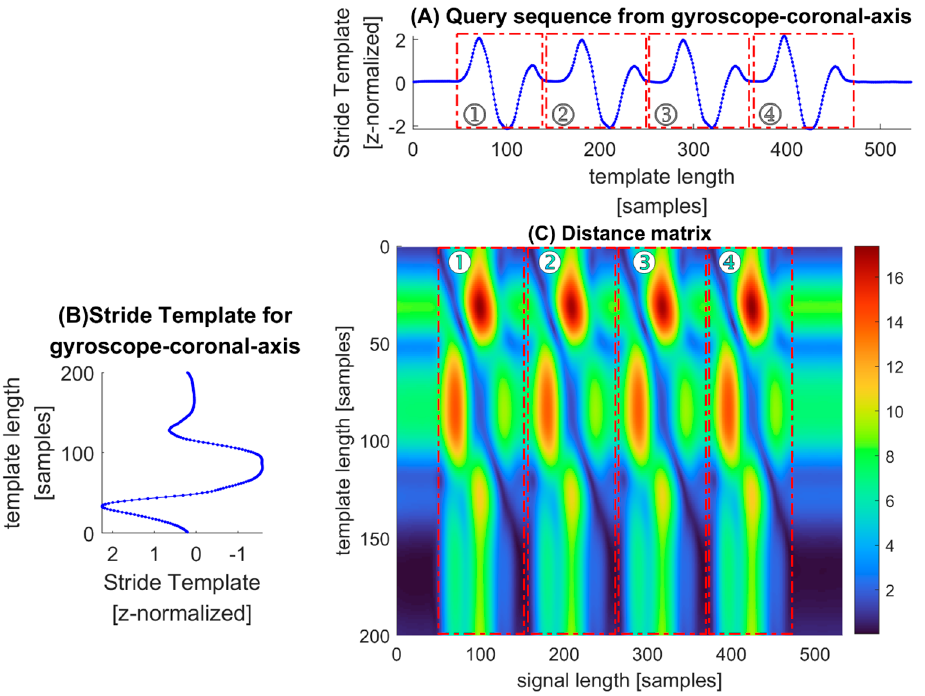
Figure 6. Distance matrix is shown as an example for calculating RAW descriptors for gyroscope- coronal-axis-data. The elements with deep blue in the distance matrix show closer spatial distance between the shape descriptor of a query sample and that of a template point, while elements with red indicate greater spatial distance. ( A ) query sequence A des ; ( B ) stride template B des ; ( C ) distance matrix dist